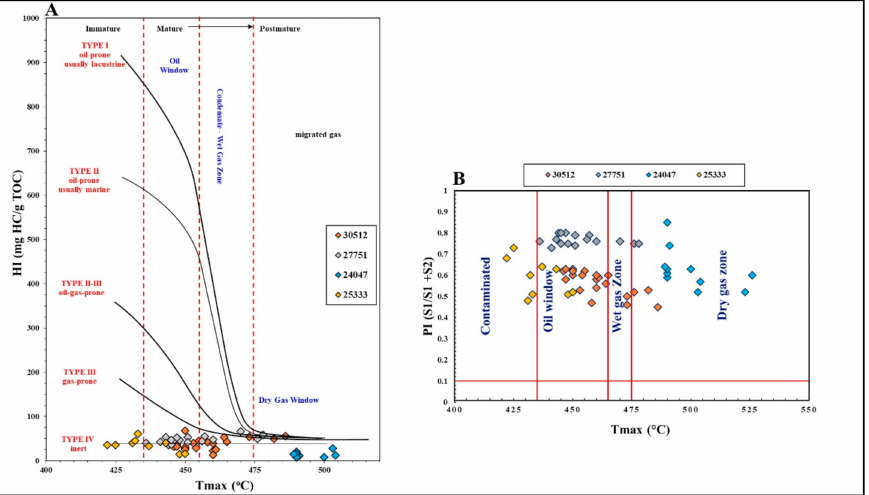
Figure 5. Thermal maturation of Montney Formation source rock, BC area, Canada. ( A ) Tmax vs. HI cross plot showing the maturation level and kerogen type. ( B ) Tmax vs. PI showing the hydrocarbon yield.